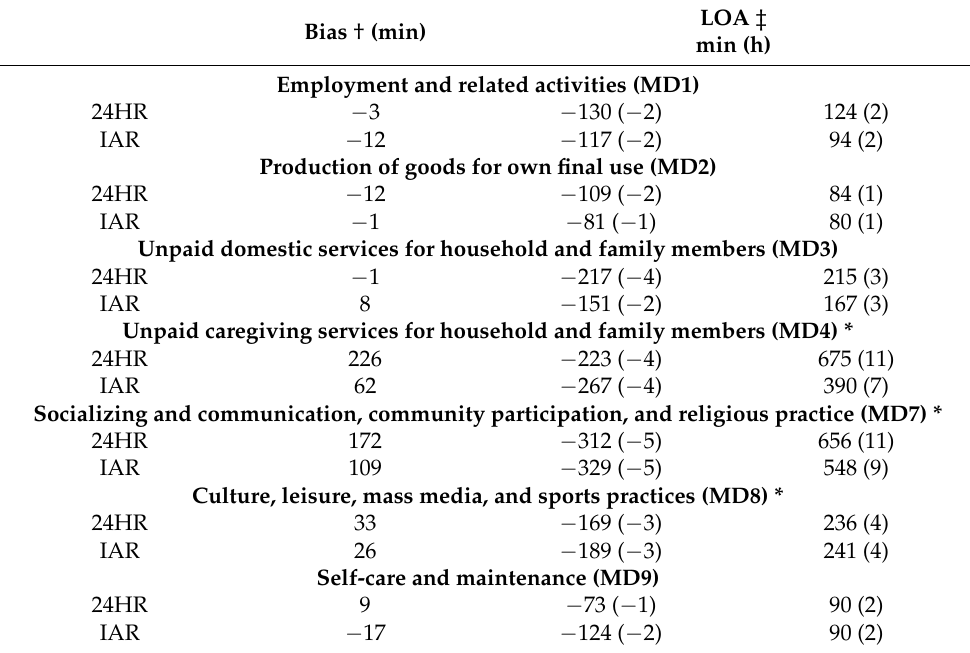
Table 3. Inter-method comparison of the time allocation bias and limits of agreement